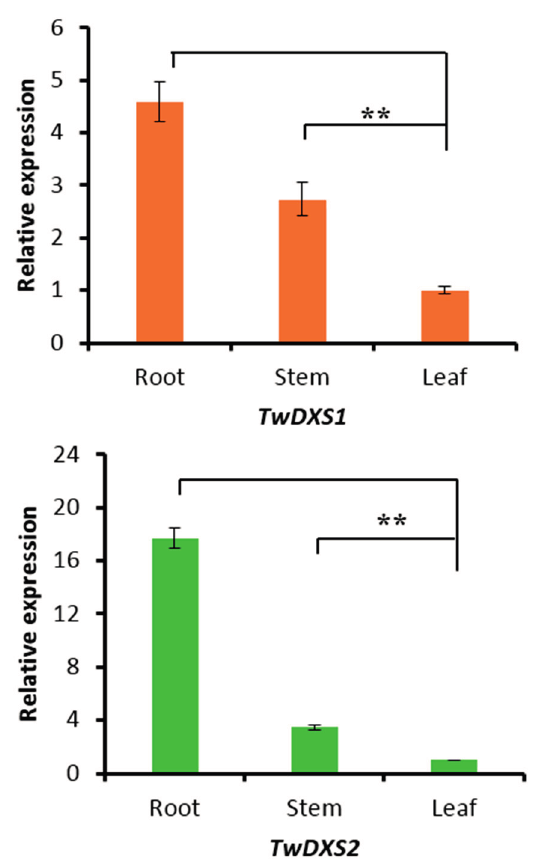
Figure 5. Expression patterns of TwDXS1 and TwDXS2 in different tissues of T. wilfordii aseptic seedling. The data represented the average of four independent experiments each carried out in triplicate; the error bars showed standard deviations. The asterisks indicated that the difference is significant compared with leaf ( ** p <